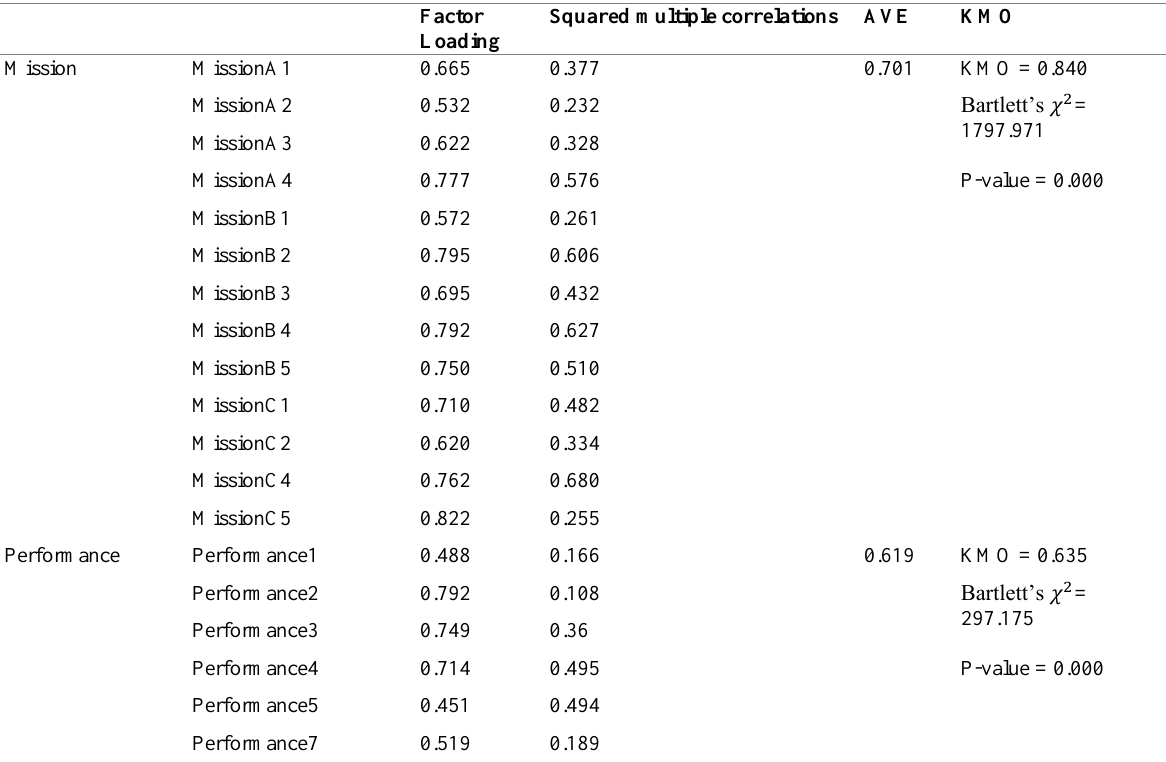
Table 7: Measurement model summary statistics